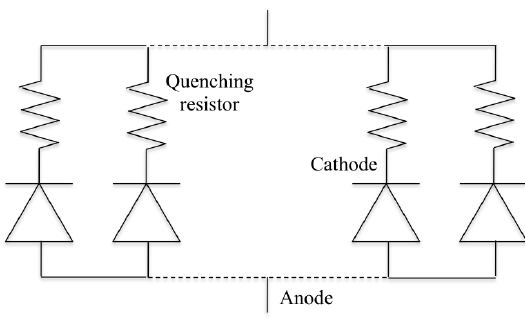
Figure 1. Schematics of a modern silicon photomultiplier (SiPM), composed of an array of single photon avalanche diode (SPAD)-like microcells with passive